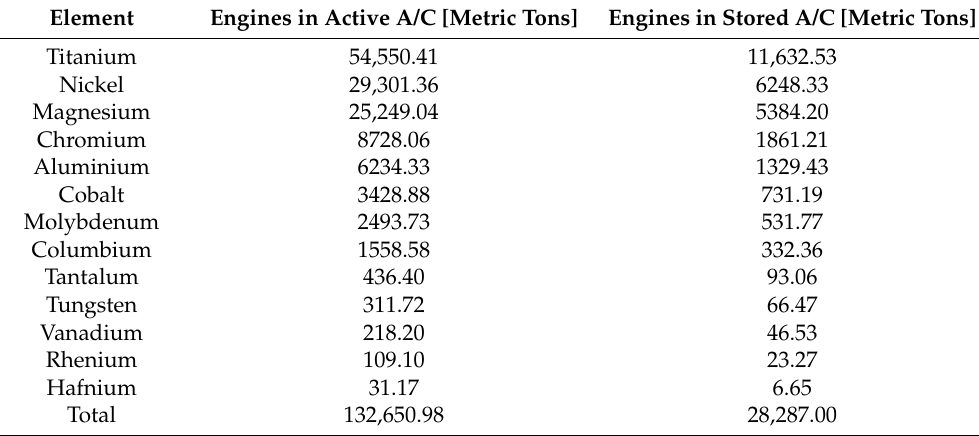
Table 3. Forecast of available material in A/C engines